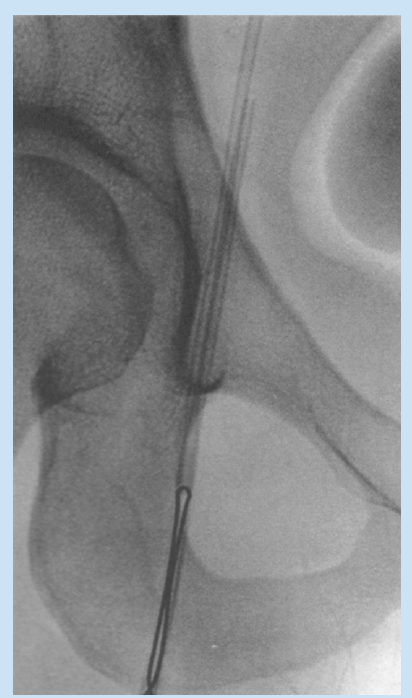
Fig. 2. Snared line fragment being recovered through sheath.